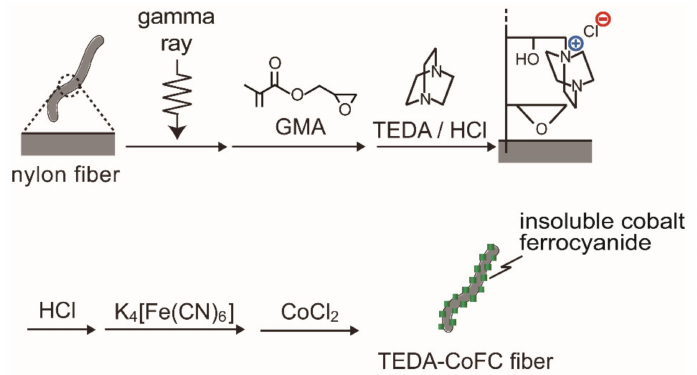
Figure 9. Impregnation scheme for insoluble cobalt ferrocyanide onto nylon